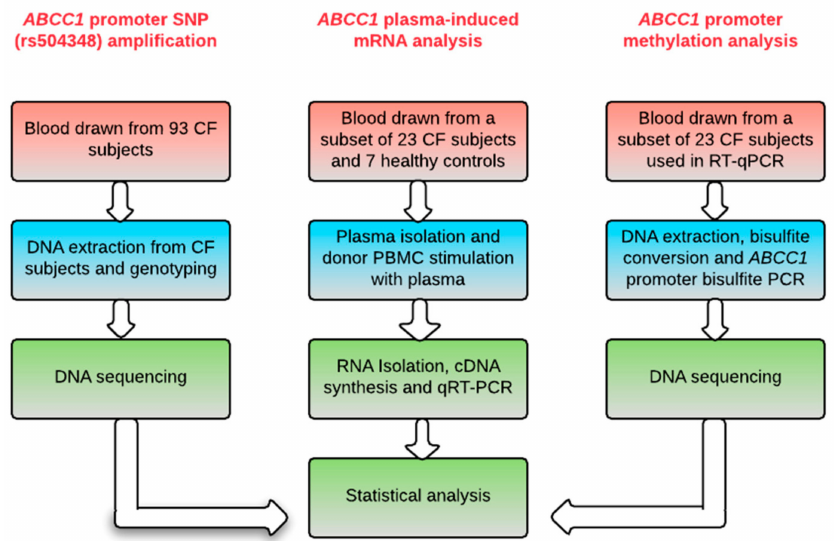
Figure 5. Schematic of experiment workflow. Peripheral blood collected from each CF subject was the primary source of genomic DNA and plasma. Genomic DNA extracted from 93 CF subjects was used for ABCC1 promoter SNP amplification. Commercial donor PBMCs from Cellular Technology Limited (Shaker Heights, OH, USA) (UPN 727) stimulated with plasma from a subset of 23 CF subjects and an additional 7 healthy control samples were used for RNA isolation and gene expression analysis via qRT-PCR. ABCC1 promoter methylation status of the subset of 23 CF samples used in qRT-PCR was determined using bisulfite